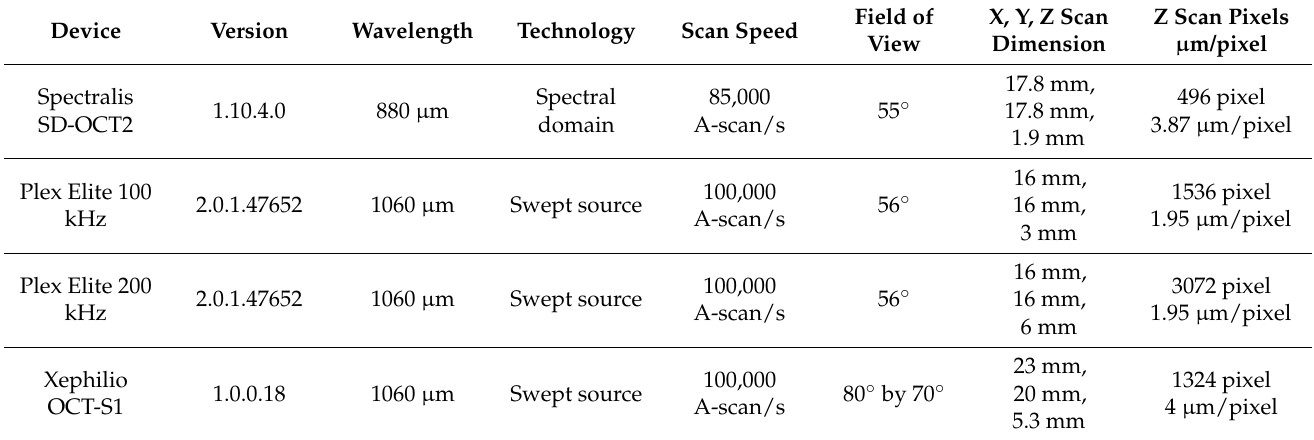
Table 1. Characteristics of optical coherence tomography